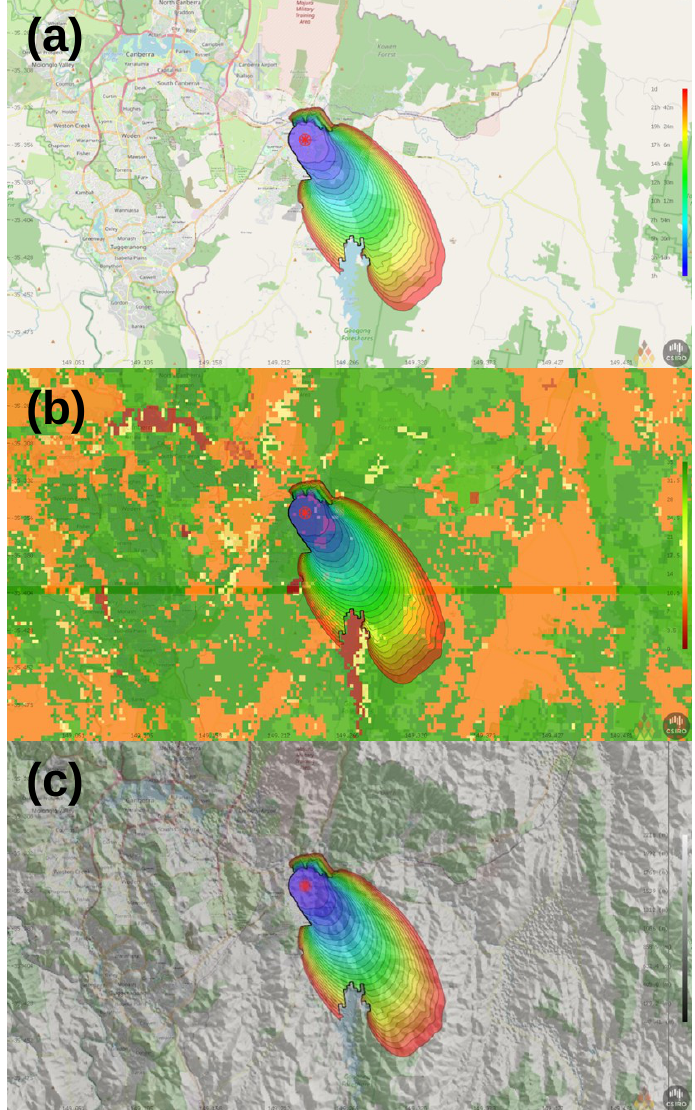
Figure 15. Simulation results of fire spread in the Queanbeyan region over a 24 h period: ( a ) basemap; ( b ) with vegetation-type basemap; ( c ) with terrain